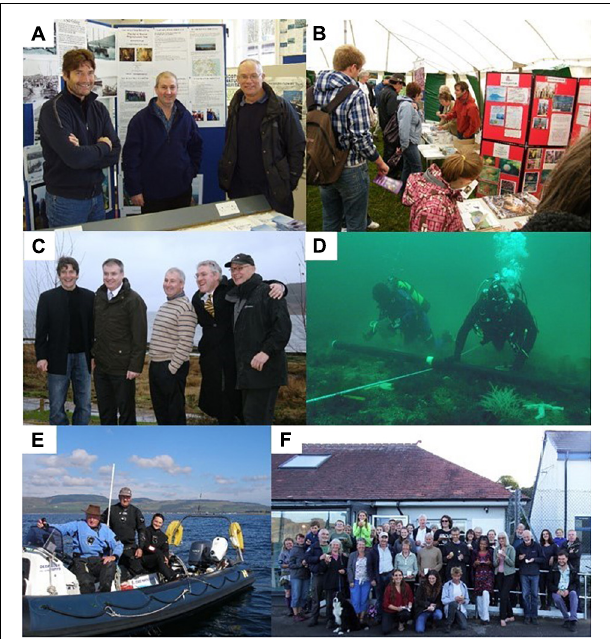
FIGURE 4 | The Story of COAST. (A) The three founding members at an outreach event in 2005 (Left to right: Don MacNeish, Howard Wood, Tom Vella Boyle); (B) COAST stall at the Arran Farmers Show, 2010 (Leigh Howarth in red coat); (C) Celebrating the designation of the Lamlash bay NTZ in 2008 (Left to right: Don MacNeish, Scottish Cabinet Secretary for Environment and Fisheries Richard Lochhead, Howard Wood, MSP Kenneth Gibson, Tom Vella-Boyle; (D) Howard Wood and Leigh Howarth doing the first SCUBA surveys of the Lamlash bay NTZ in 2010; (E) Surveying the South Arran MPA, 2014 (Left to right: Gus Robson, Howard Wood, Claire Youdale); (F) Celebrating the 10 th Anniversary of the Lamlash bay NTZ at the opening of the Octopus Centre, 2018. All identifiable persons in these figures have given consent for their images to be reproduced and used publicly.